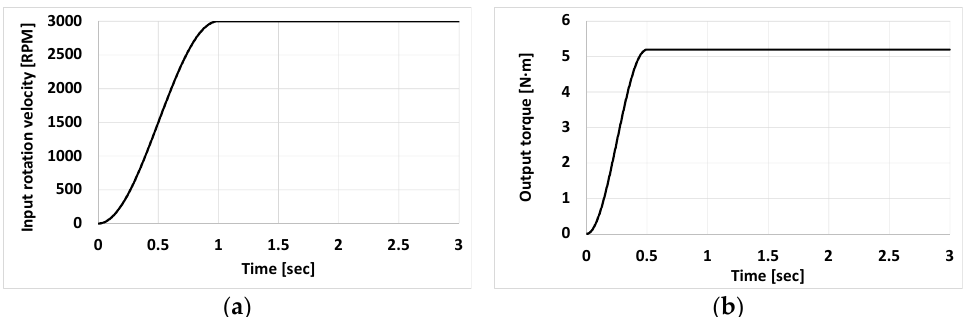
Figure 12. Torque according to motor’s rotational velocity: ( a ) Input rotational velocity; ( b ) Output torque.